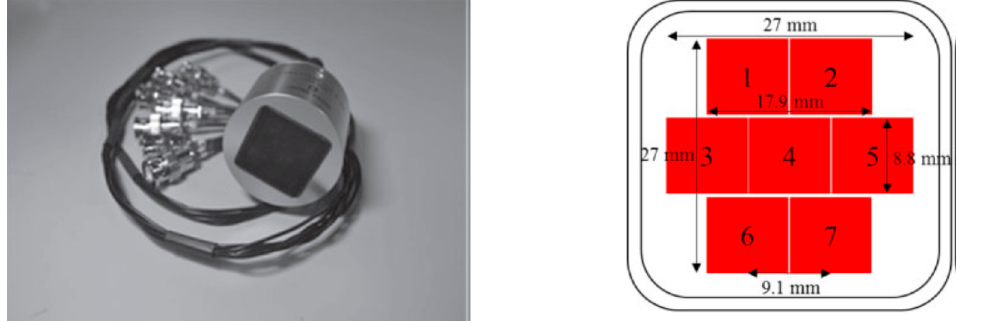
Figure22. ( a )Heavymatchinglayertransducerand( b )itsinternalconfiguration. Reproducedfrom[448] Figure 22. ( a ) Heavy matching layer transducer and ( b ) its internal configuration. Reproduced from with permission from Copyright (2016) The Japan Society of Applied [448] with permission from Copyright (2016) The Japan Society of Applied Physics.